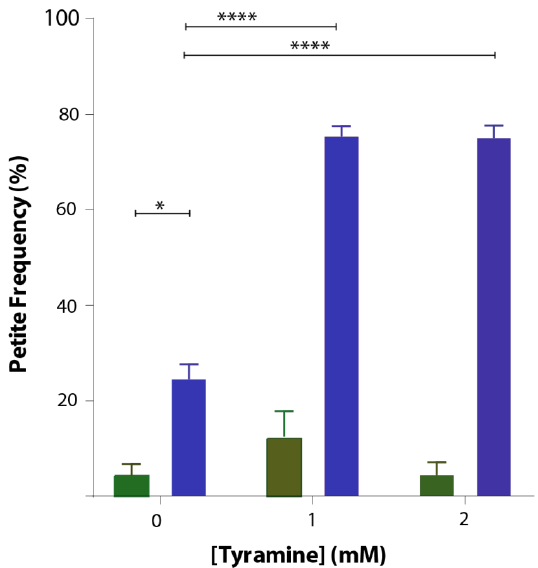
Figure 5. Petite frequency of S. cerevisiae BY4743 (p416GPD.GFP) (green bar) and BY4743 ( p416GPD.GFP.Aβ ) (blue bar) transformants treated with 0, 1 and 2 mM tyramine. Values are from triplicates, and values significantly different in two-way ANOVA are indicated by asterisks (* p < 0.05 and **** p < 0.0001).